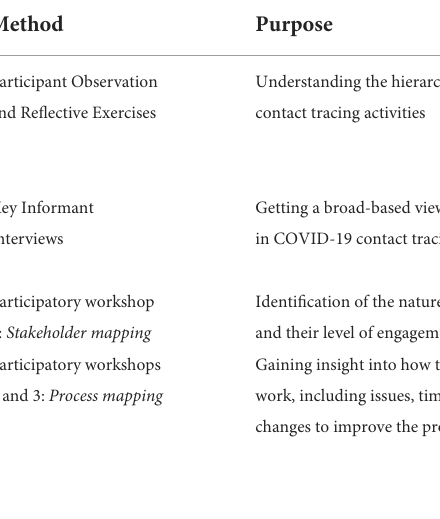
TABLE 1 Systems approaches used and their